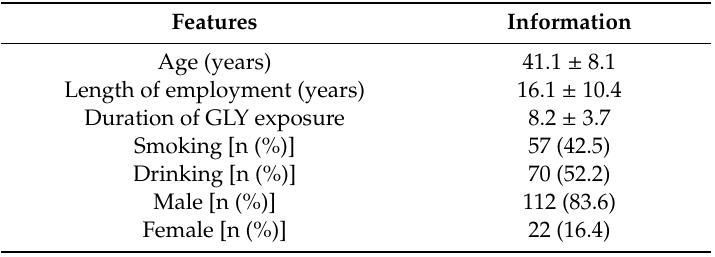
Table 1. The information of the subjects (N = 134).